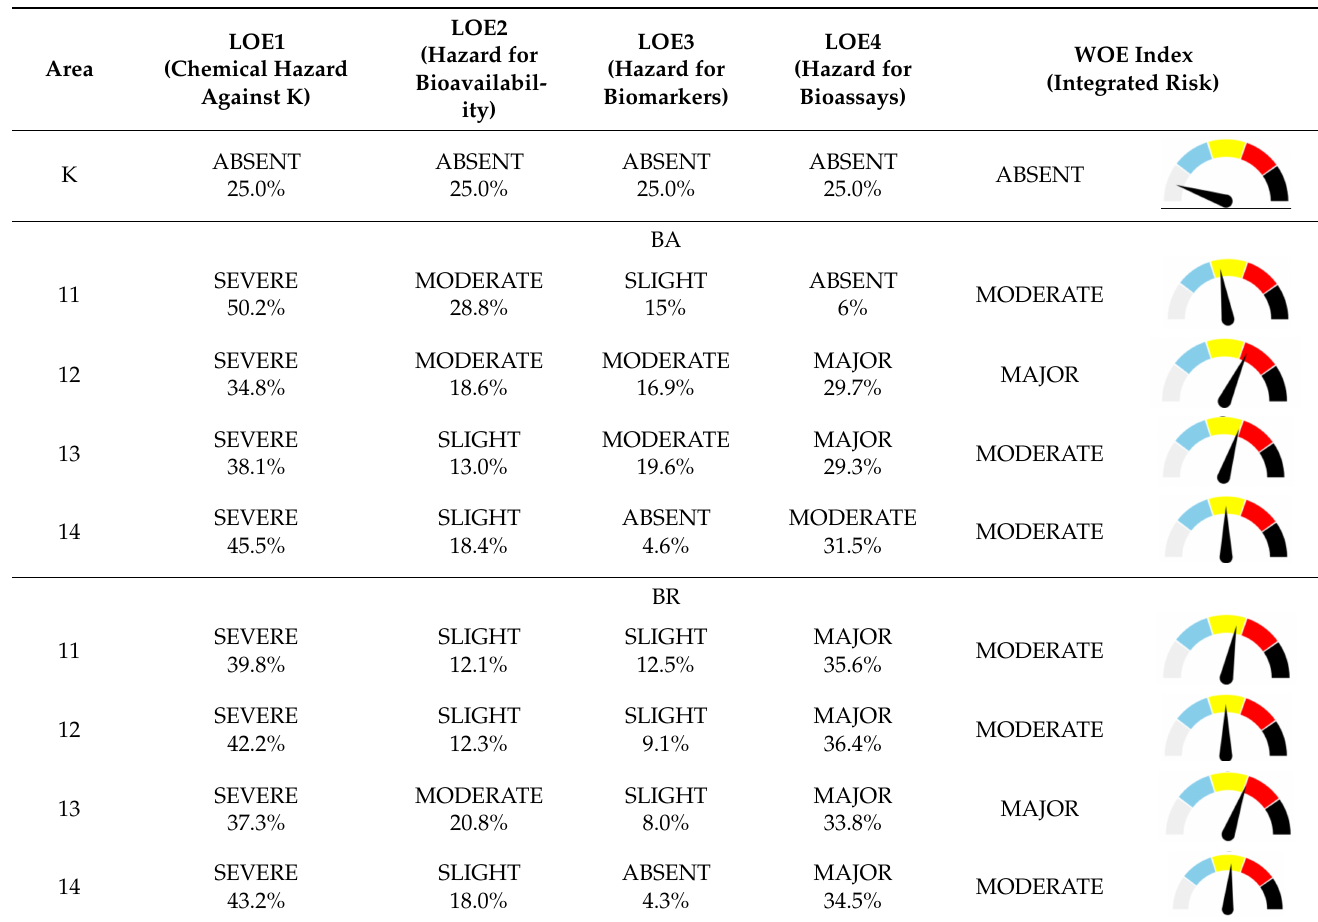
Table 7. Classification of hazard level and WOE index for sediments sampled around offshore platforms called BA and BR and control area K, with the Chemical hazard (LOE1) estimated using reference area (K) values. The contribution to the WOE (as %) is reported for each